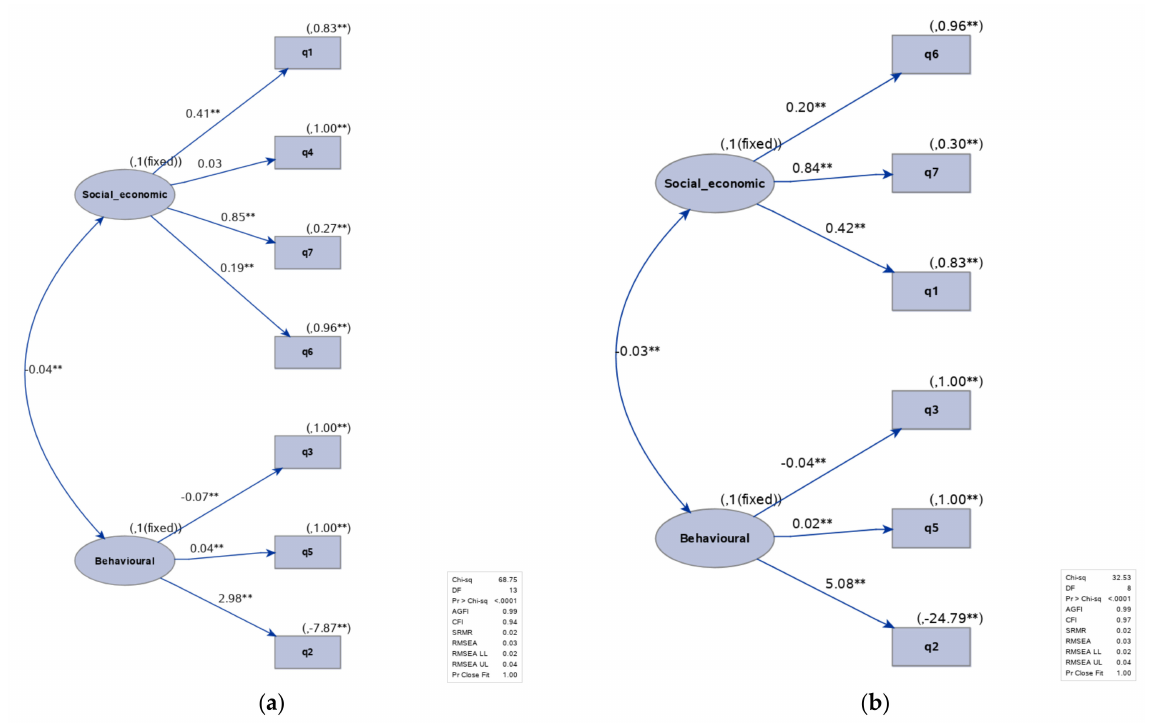
Figure 8. Path diagrams for the data set of the pre-trial questionnaire ( a ) initial ( b ) after modification.